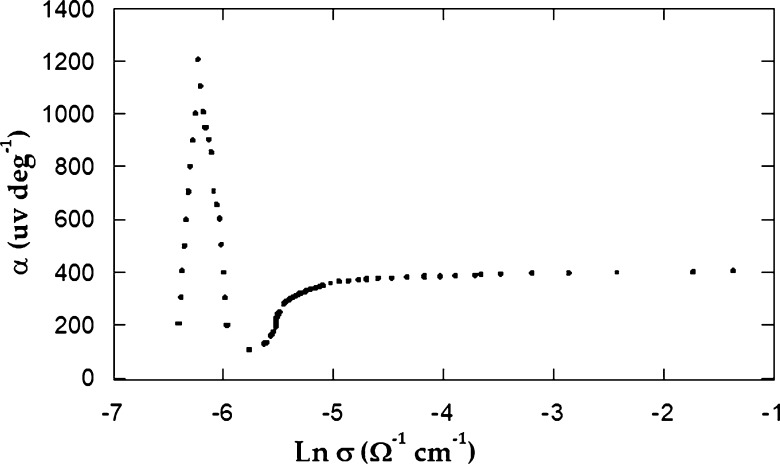
The TEP versus ln σ for CuGaSe2 single crystals.